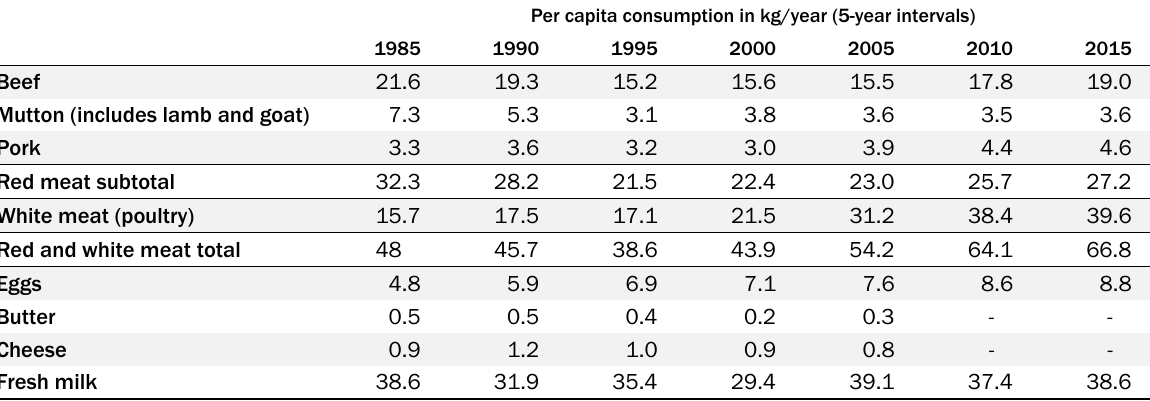
Table 2. South African per Capita Consumption Dynamics for Livestock-Derived Food Groups, Showing Five-Year Interval